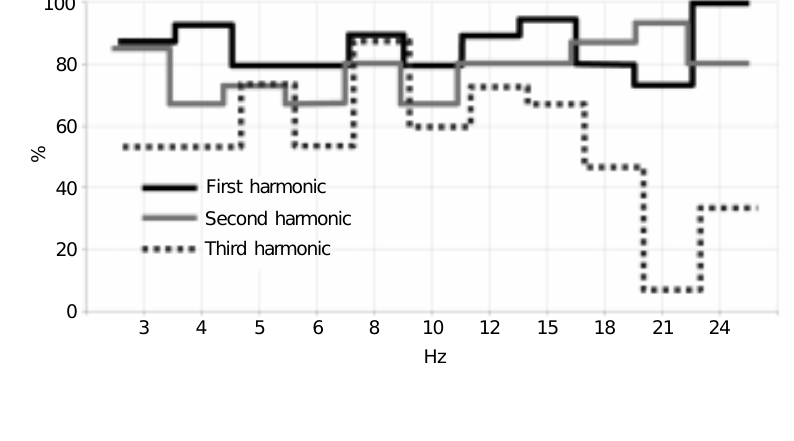
Figure 3. Percentage of subjects showing a driving response (according to the criterion of peak values 20% larger than those of adjacent frequencies) in the first three harmonics of each frequency of the first series of intermittent photic stimulation. A hun- dred percent indicates a driving response in all 15 subjects of the group studied.